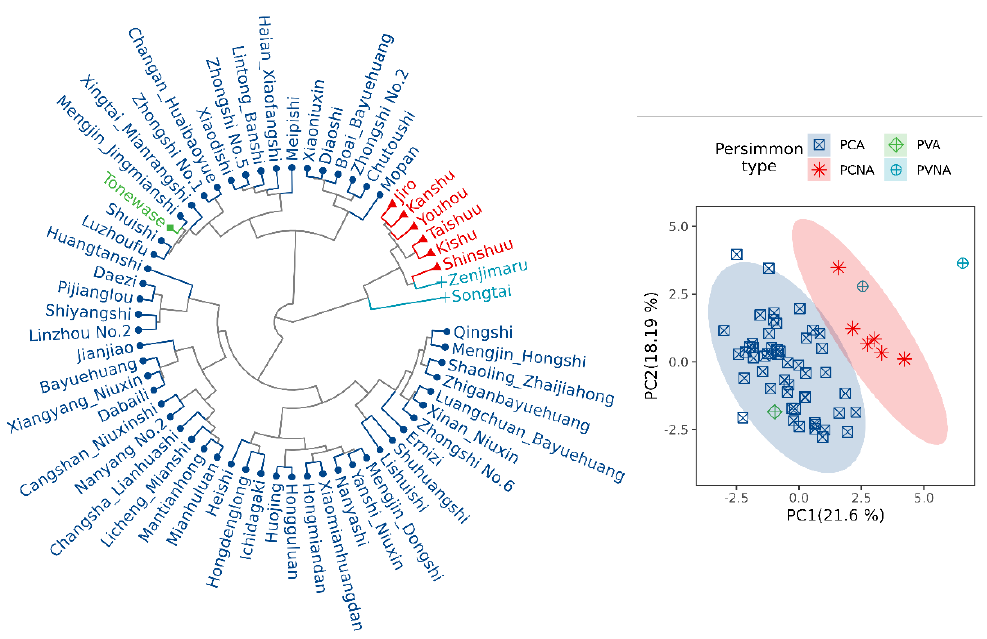
Figure 4. Cluster analysis and principal component analysis of 61 different persimmon cultivars .